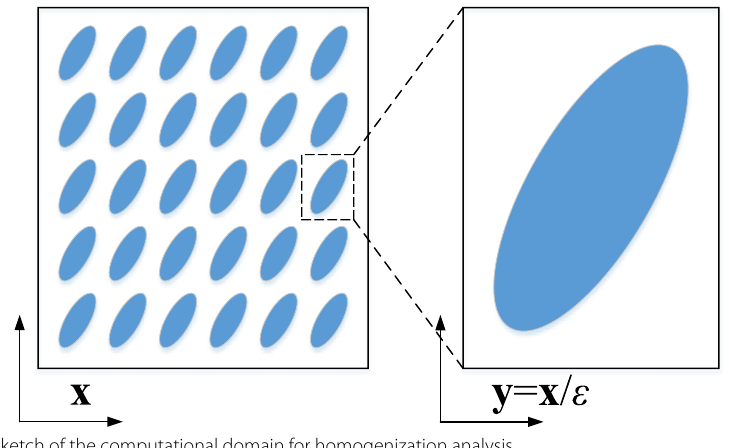
Fig. 1 Sketch of the computational domain for homogenization